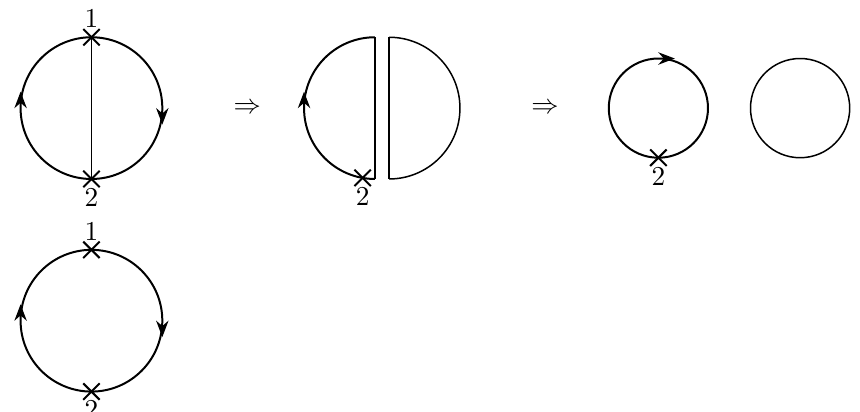
Figure 2 . Computing C 2 . The above graphs correspond to the two possible set partitions for 1 ; 2 . The (cid:12)rst graph depicts the case when r 1 and r 2 coincide. Thus, these two crosses are joined. f g After thickening the chord and erasing the cross with the smaller label, the graph splits into a loop with one cross labeled 2 and a loop with no crosses. The second graph depicts the case when r 1 = r 2 . Here, there is no joining of crosses and the graph just remains as is. 6